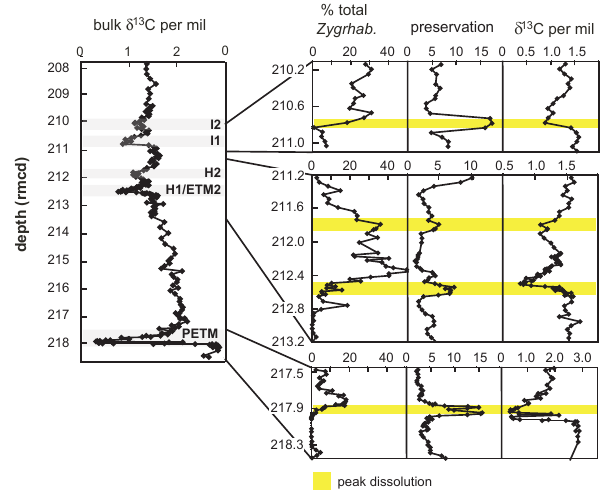
Fig. 6. Relationships between dissolution, the CIEs and the abun- dance of Zygrhablithus . The nannofossil-based preservation index uses the ratio of indeterminate Toweius to identifiable Toweius with higher values indicating higher levels of dissolution (Gibbs et al., 2006a, 2010). The peak in Zygrhablithus associated with each CIE occurs at the start of the carbon isotope recovery in each case and is consistently above the level of peak dissolution (highlighted in